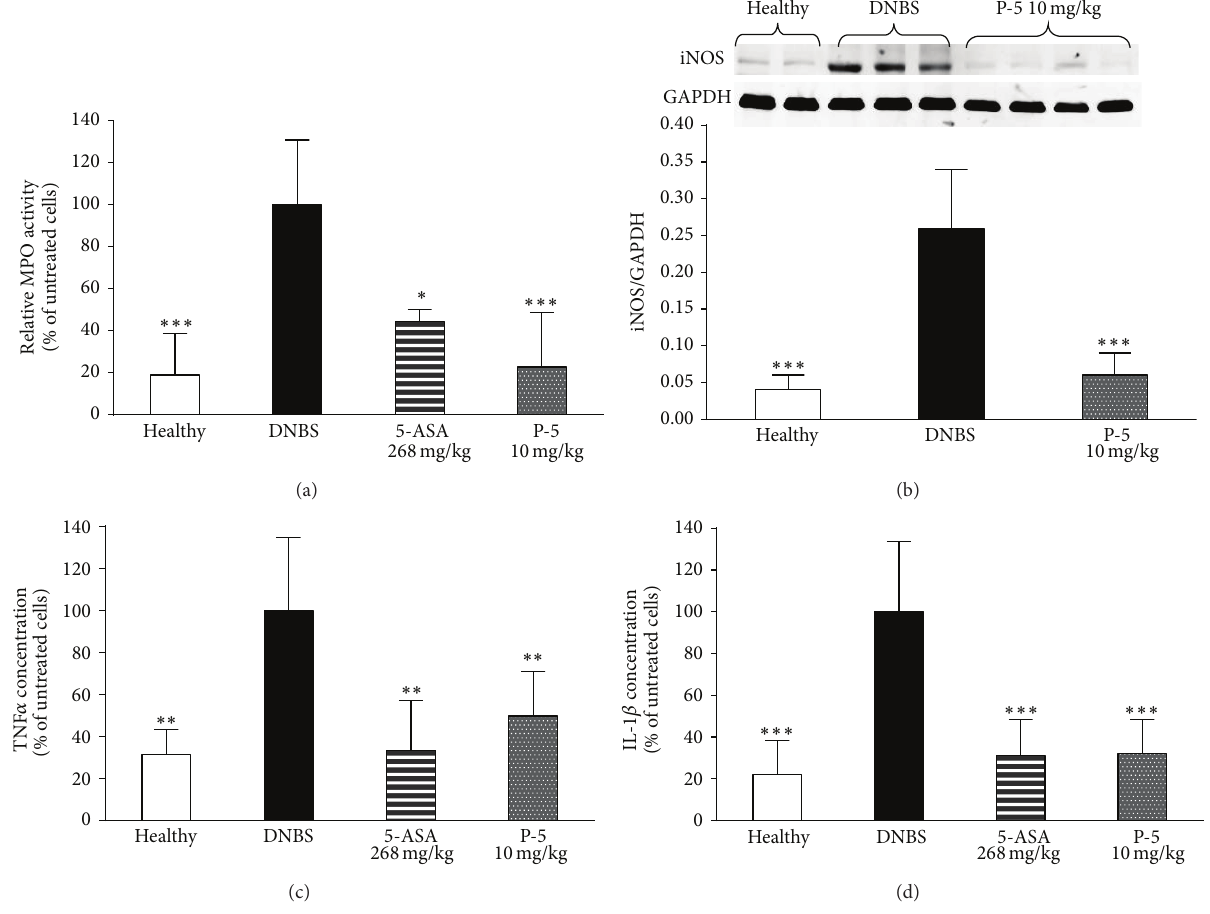
Figure 6: MPO activity (a), iNOS expression (b), TNF 𝛼 (c), and IL-1 𝛽 (d) tissue levels in the colons of healthy rats, untreated DNBS-induced rats, and DNBS-induced rats treated with P-5 and 5-ASA. Results are normalized to total tissue protein. (a), (c), and (d) are expressed as a fraction (in %) of the tissue biomarker levels in the DNBS-treated group. (b) is normalized to the house keeping gene, GAPDH. Shown are the mean ± S.D. values of 3–7 rats in each group. ANOVA of the effect of P-5 on MPO activity was F 3,19 = 13.63 𝑝 < 0.0001 , on iNOS expression was F 2,18 = 37.57 𝑝 < 0.00001 , on TNF 𝛼 level was F 3,22 = 9.00 𝑝 < 0.001 , and on IL-1 𝛽 level was F 3,31 = 22.61 𝑝 < 0.00001 . ∗ 𝑝 < 0.05 ; ∗∗ 𝑝 < 0.01 ; ∗∗∗ 𝑝 < 0.001 compared with the DNBS